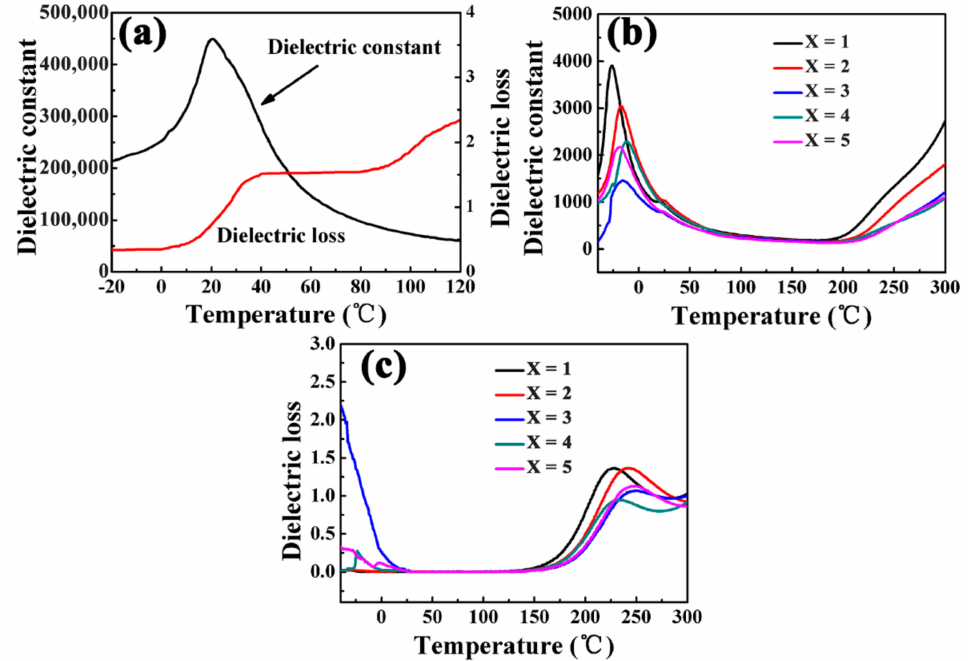
Figure 9. Dielectric constant-temperature curves of the ( a ) BST and ( b ) BST- x mol% MgO (x = 1, 2, 3, 4, 5) ceramics. ( c ) Dielectric loss-temperature curves of BST- x mol% MgO ( x = 1, 2, 3, 4, 5)